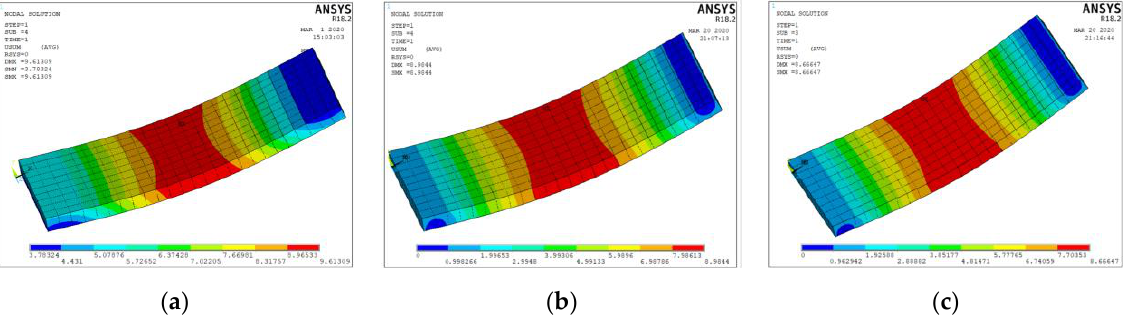
Figure 17. Deflection nephogram of composite floor with different steel thickness: ( a ) 1.0, ( b ) 1.5 and ( c ) 2.0 mm.